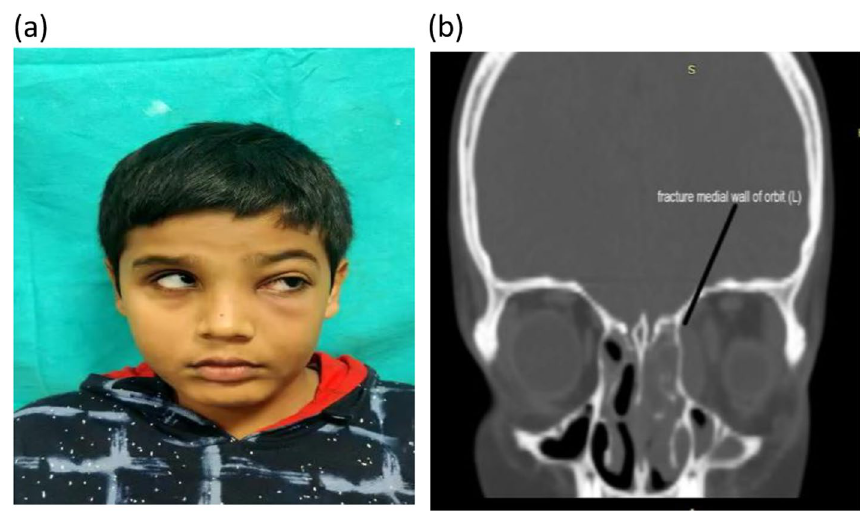
Fig. 3 a , b Representative images of case series 2. a (L) periorbital swelling, mild erythema, Proptosis (L) eye, restricted superior gaze in a case of complicated rhinosinusitis with subperiosteal abscess. b CT PNS image showing fracture of medial wall of (L) orbit, subperiosteal hematoma along medial wall of (L) orbit with proptosis, indentation of (L) medial rectus. Hemosinus in (L) ethmoidal air cells and mucosal thickening involving all paranasal sinuses